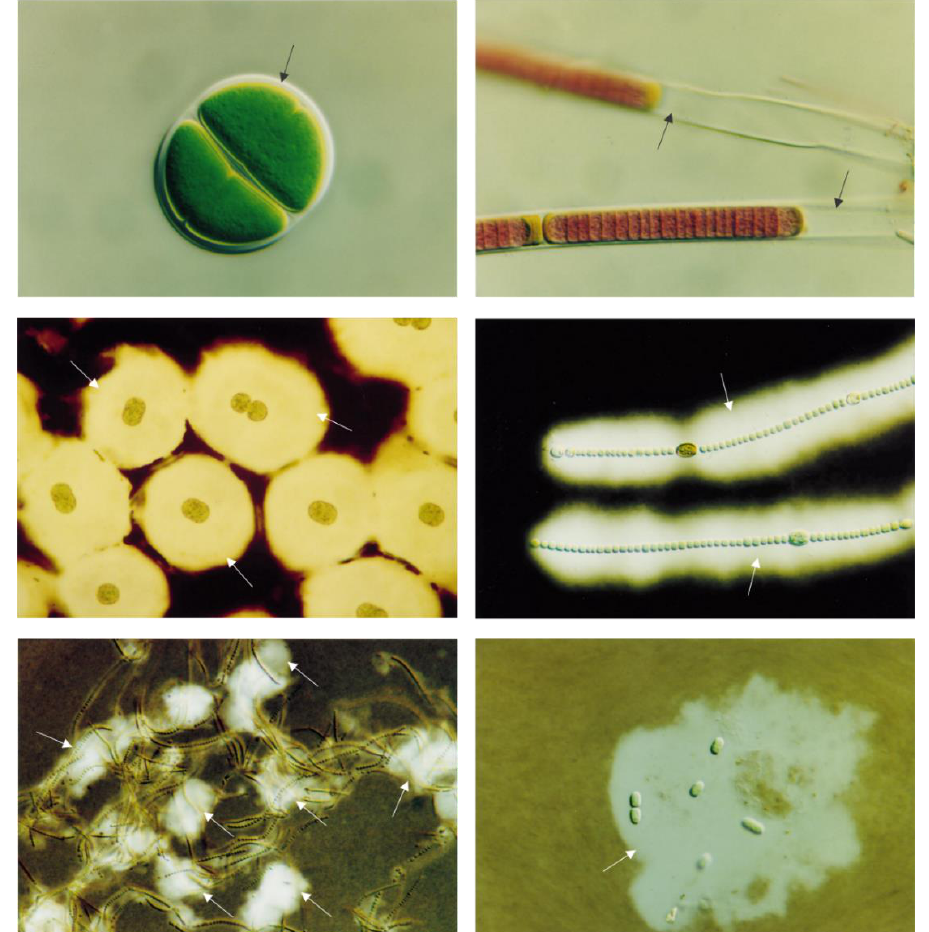
Figure 6. Types of exopolysaccharides (indicated by black and white arrows); top row — thin and dense layer named sheath structure (left — Chroococcus sp. (1000×); right — Phormidium sp. (1000×)); middle row — the thick layer resembles a cell shape named capsules (left — Cyanothece CE 4 (775×); right — Nostoc sp. (480×); bottom row — thick layer without cell shape resemblance named slime (left — Cyanothece PCC9224 (775×); right — Nostoc PCC7906 (194×). Reprinted from De Philippis, R.; Vincenzini, M. Exocellular polysaccharides from cyanobacteria and their possible applications. FEMS Microbiol. Rev. 1998, 22, 151–175, doi:10.1111/j.1574-6976.1998.tb00365.x, with permission from Elsevier.